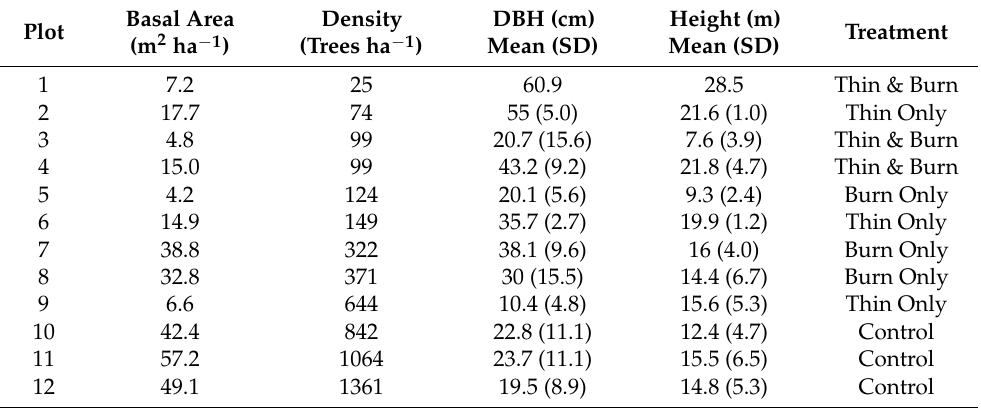
Figure 2. Study site location map showing ponderosa pine forest structural conditions in each of four treatment areas encompassing an increasing tree density gradient (thin and burn, thin only, burn only, and control) for the “Rudd Tank” study site in northern Arizona, USA. Also depicted are the extents sampled using mobile laser (lidar) scans (MLS; orange) and the terrestrial laser scans (TLS; dark red), and locations of twelve 0.04 ha plots (dashed black lines) and sixteen TLS scan stations (white triangles). Table 1. Summary of field data for sample plots (n = 12) used as validation in this study, arranged by increasing tree (trees ha − 1 ).